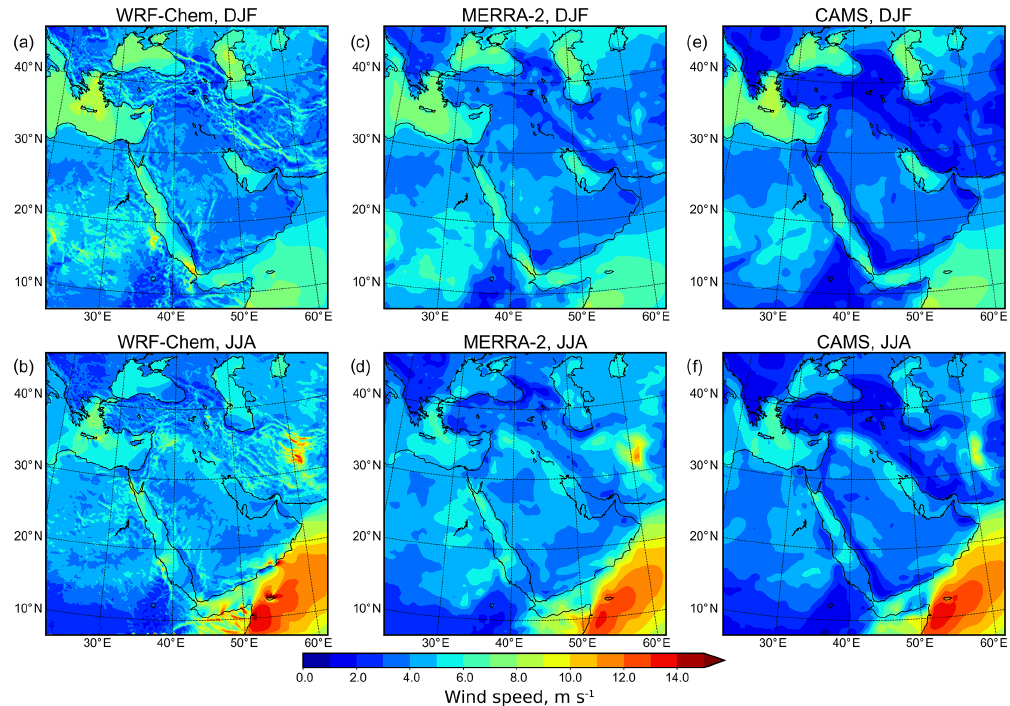
Figure 3. Seasonally averaged (2015–2016) wind speed at 10m from WRF-Chem, MERRA-2, and CAMS-OA during winter (DJF) and summer